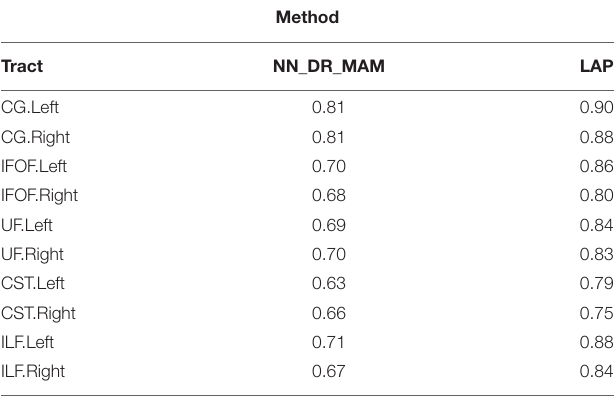
TABLE 2 | Summary of the results: The average area under the Receiver operating characteristic (ROC) analysis between segmented tracts and ground truth tracts for the NN_DR_MAM and the proposed